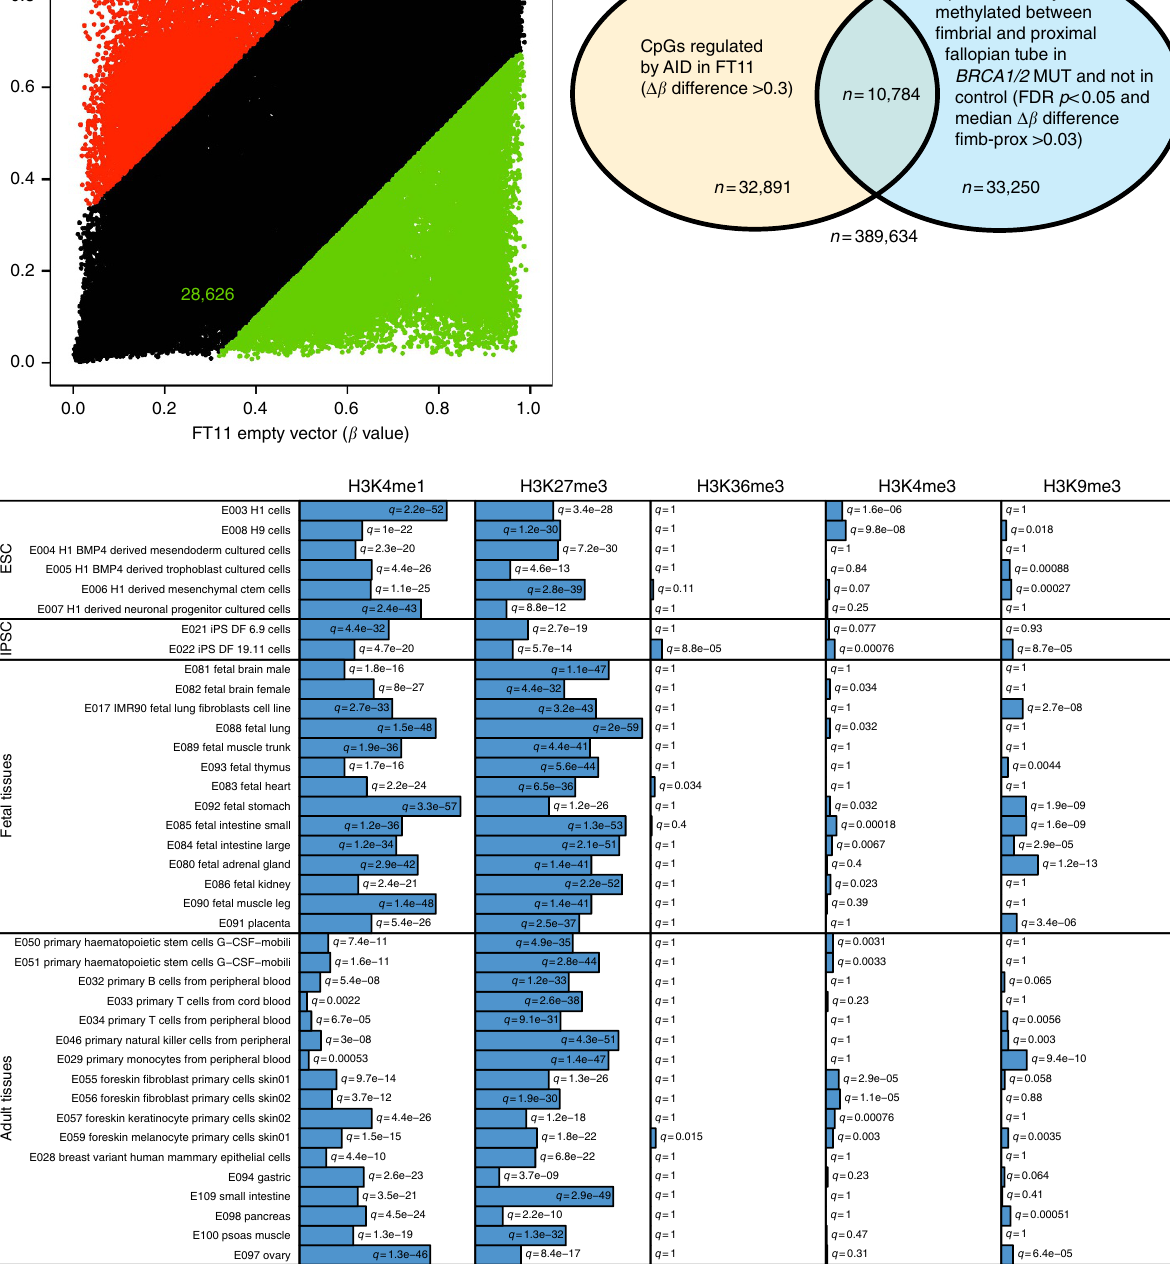
Figure 5 | AID-mediated epigenetic reprogramming in primary cultures of fallopian tube epithelium. ( a ) Scatter-plot showing b values in AID- overexpressing FT11 cells compared with FT11 cells transfected with the empty vector. CpGs with D b 4 0.3 are coloured red and green respectively for hyper- and hypo-methylated CpGs in AID-overexpressing cells, with the numbers of CpGs categorized in this way indicated in these respective colours. ( b ) Venn-diagram illustrating significant overlap (with p -value calculated with Fisher’s exact test) between CpGs that are differentially methylated between fimbrial and proximal fallopian tube compartments and in FT11 cells force-expressing AID. ( c ) eFORGE q -values (for explanation see Fig. 2) for overlap between the 1,000 CpGs showing the greatest hypomethylation differences between cells force-expressing AID and H3K4me1, H3K27me3, H3K36me3, H3K4me3 and H3K9me3 peaks from the Roadmap Epigenomics consortium (consolidated epigenomes release 2015, covering 39